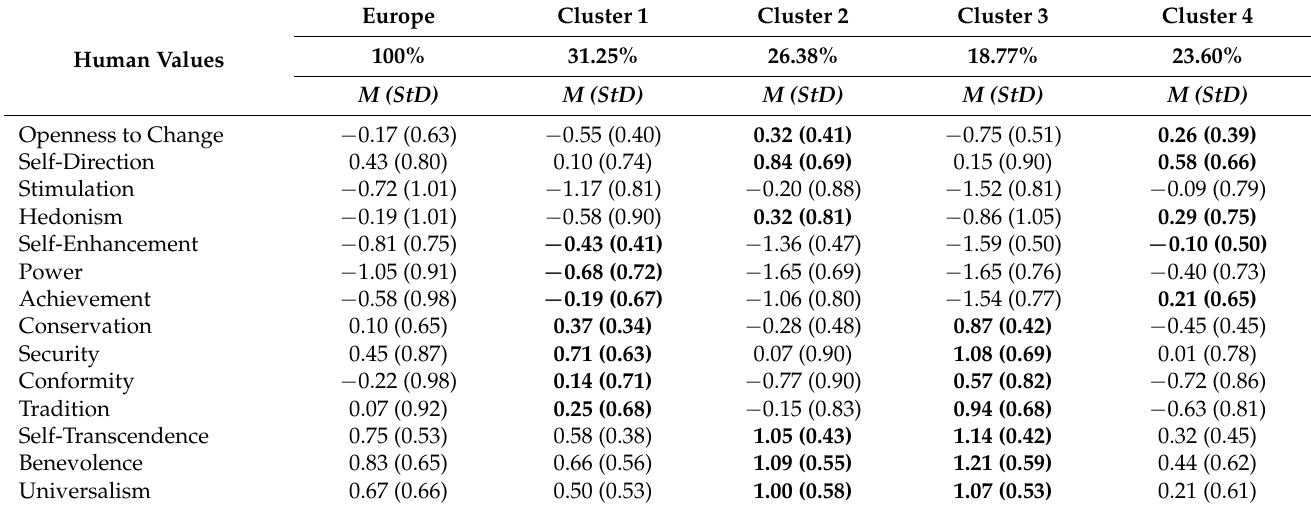
Table 2. Comparison of the centered means ( M) and standard deviations ( StD ) of the Schwartz’s basic and higher order value priorities for Europe and for the clusters found (weighted samples).